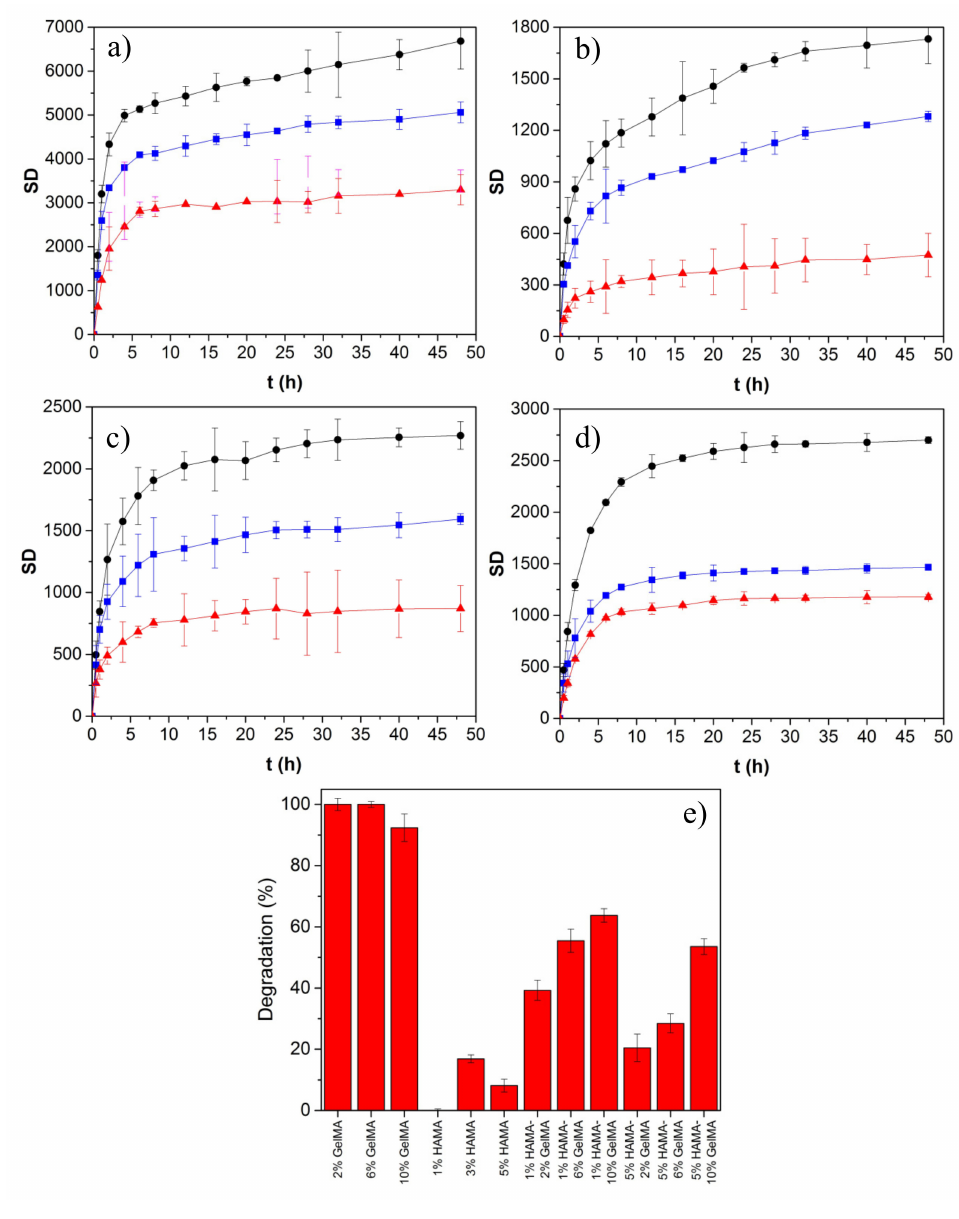
Figure 7. Swelling kinetic data for ( a ) pure HAMA hydrogels of ( • ) 1, ( (cid:4) ) 3, and ( (cid:78) ) 5%; ( b ) pure GelMA ones of ( • ) 2, ( (cid:4) ) 6, and ( (cid:78) ) 10%; and hybrid HAMA-GelMA ones of ( c ) ( • ) 1–2, ( (cid:4) ) 1–6, and ( (cid:78) ) 1–10%; and ( d ) ( • ) 5–2, ( (cid:4) ) 5–6, and ( (cid:78) ) 5–10%, respectively. ( e ) Degradation of scaffolds by enzymatic attack after 24 h of incubation at 37 ◦